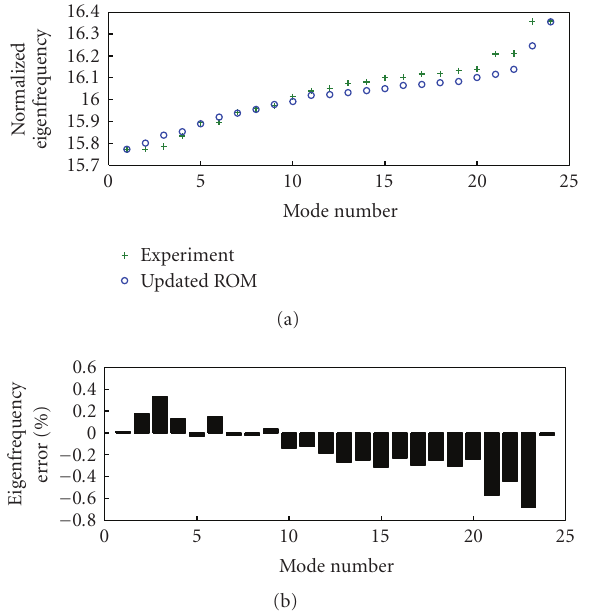
Figure 11: Error in natural frequencies.